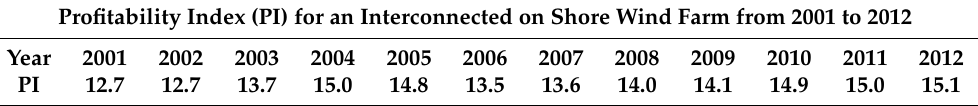
Table 8. The profitability index (PI) for an interconnected onshore wind farm from 2001 to 2012. Profitability Index (PI) for an Interconnected on Shore Wind Farm from 2001 to